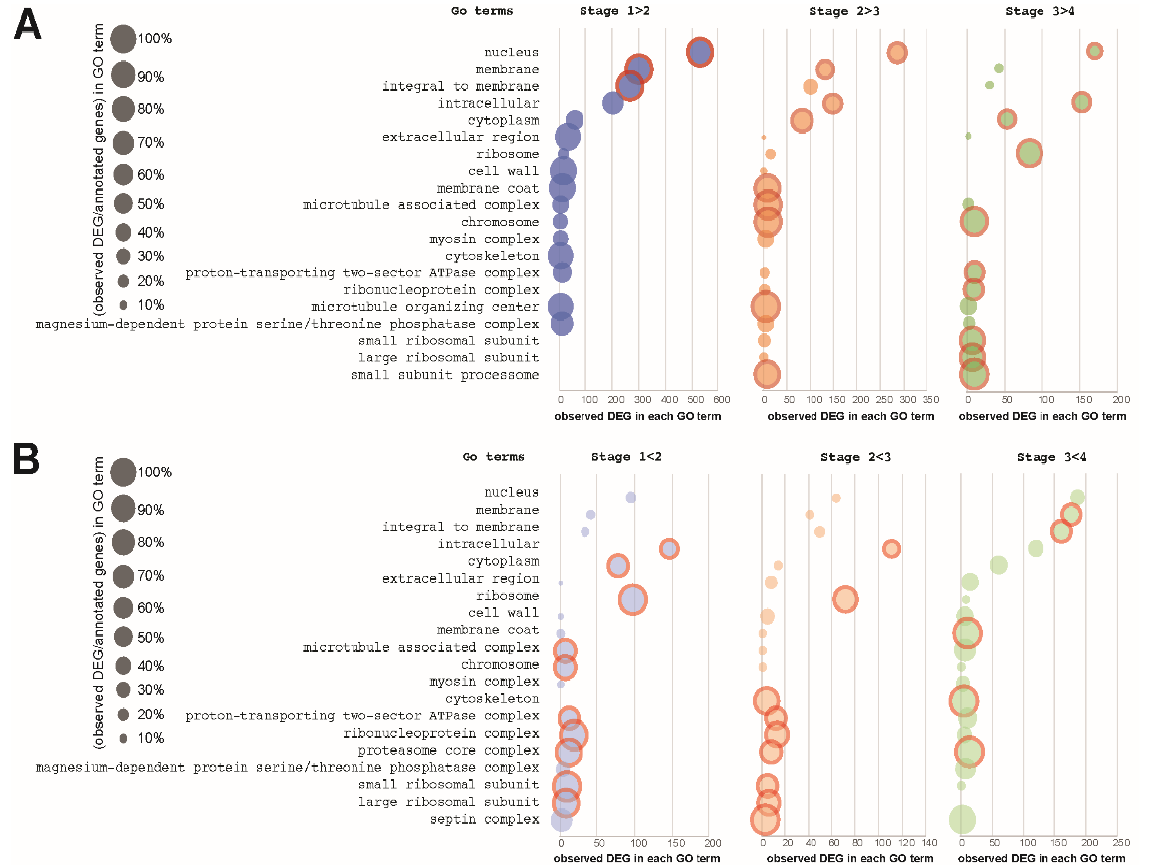
Figure 3. Selected 20 GO terms among the cellular components showing divergent enrichment patterns during phases of conidial germination of T. asperelloides . ( A ) Differentially expressed genes (DEGs) that were significantly downregulated during the process; ( B ) DEGs that were significantly upregulated during the process. Enrichment status is color-coded for different stage shifts. The bubble plot was scaled with the percentage of observed DEG for each GO term. Significantly enriched GO terms (Benjamini – Hochberg adjusted p < 0.05) are circled with red.